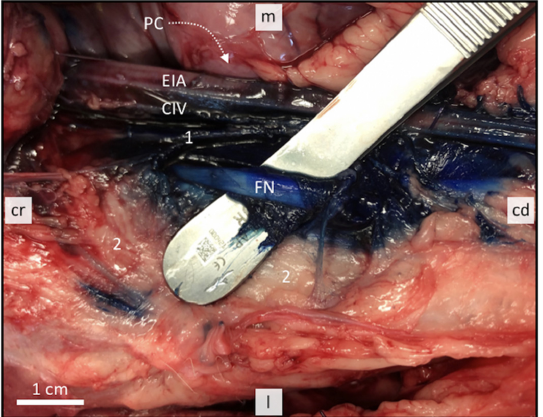
Figure 4. Dissection of a successfully stained right femoral nerve after lateral subiliac iliopsoas com- partment injection with 1% methylene blue dye. The nerve was mobilized from the iliopsoas com- partment to assess staining. 1 = psoas minor muscle; 2 = psoas major muscle and medial part of iliac muscle covered by fat; PC, pelvic cavum; EIA, external iliac artery; CIV, common iliac vein; FN, femoral nerve; cr, cranial; cd, caudal; m, medial; l, lateral.